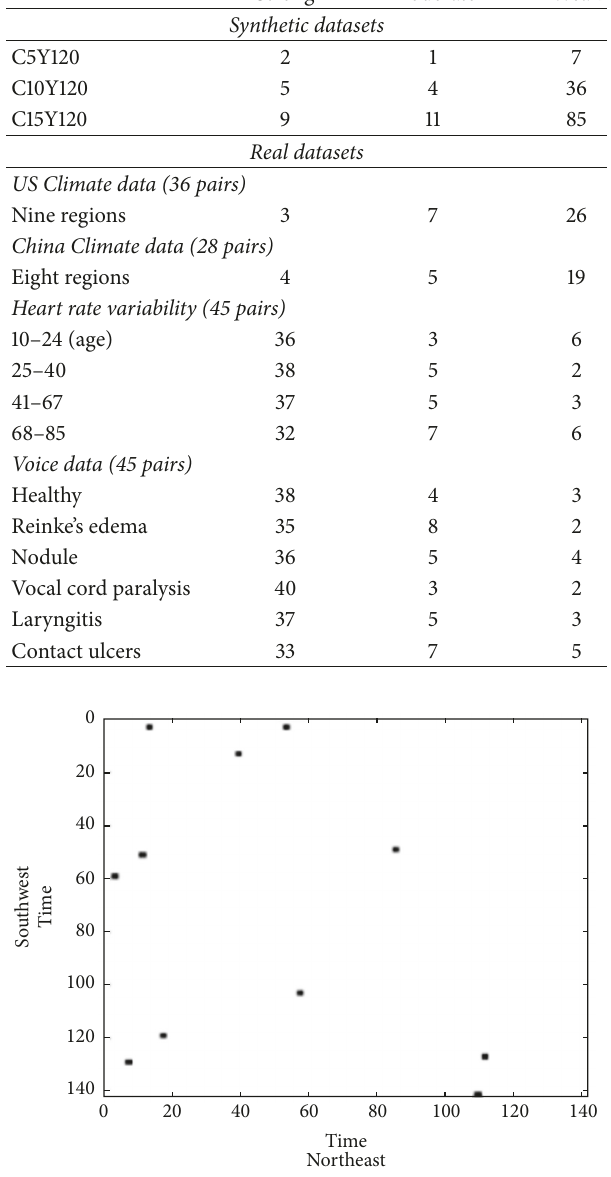
The statistical methods used to resolve this query are known as multiple paired comparison procedures. We calculated the hypothesis by using two-tailed significance level estimates ( 𝑧 -